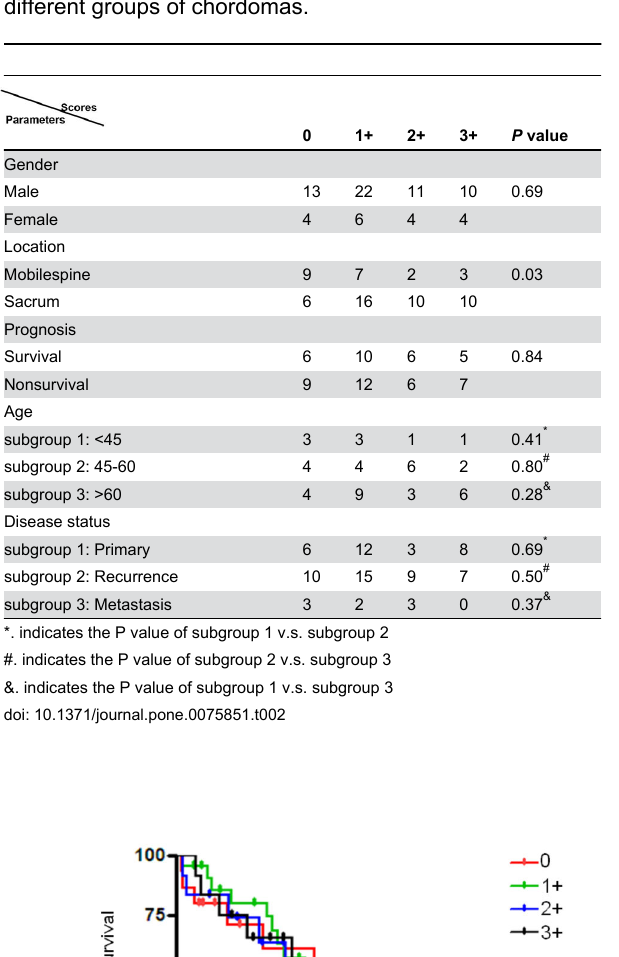
Table 2. Brachyury immunohistochemical staining scores in different groups of chordomas.